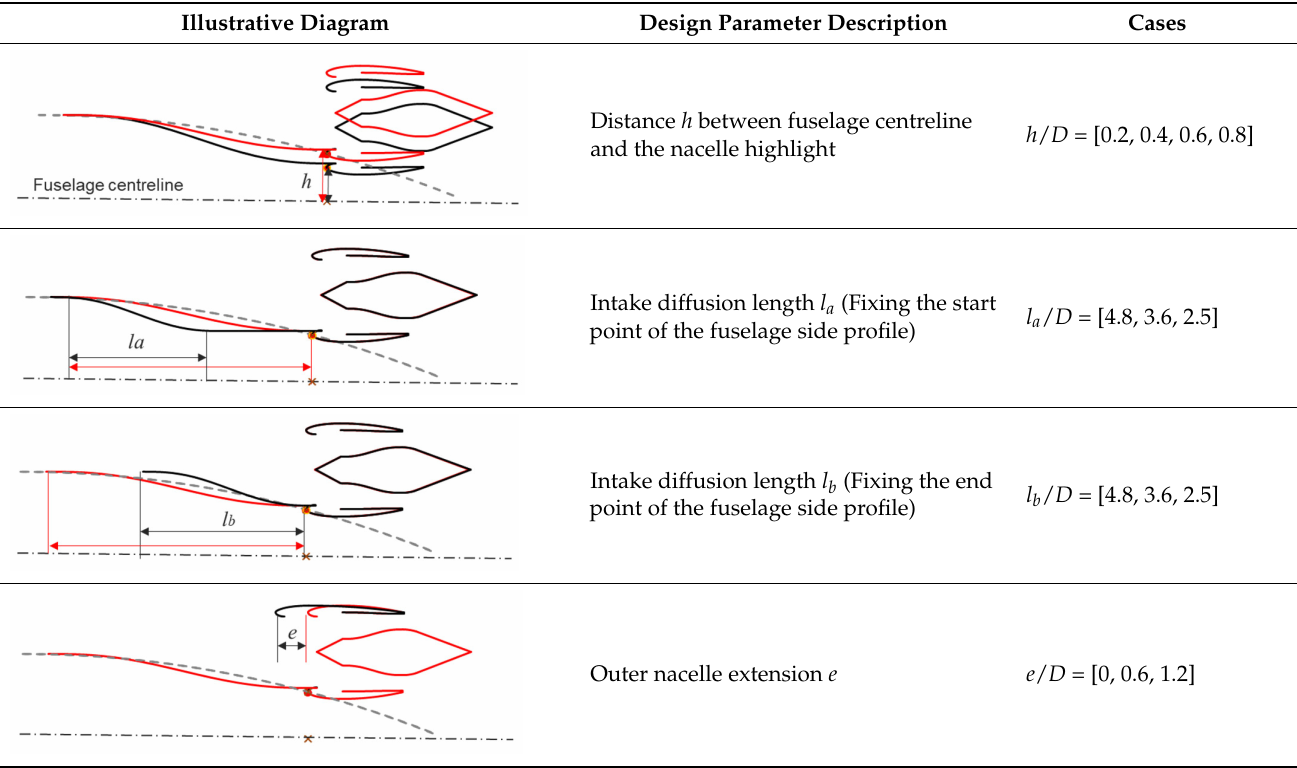
Table 1. Overview of the engine integration design parameters for the sensitivity